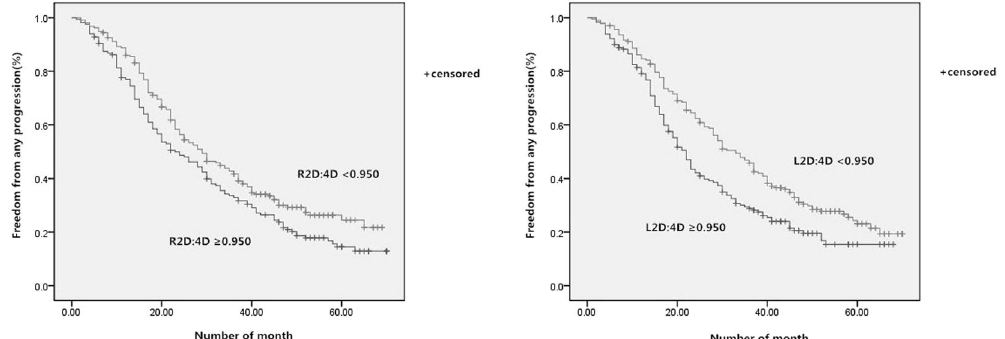
Figure 2. Kaplan–Meier curves for any progression free survival, according to the R2D:4D and L2D:4D ( < 0.950 versus ≥ 0.950).